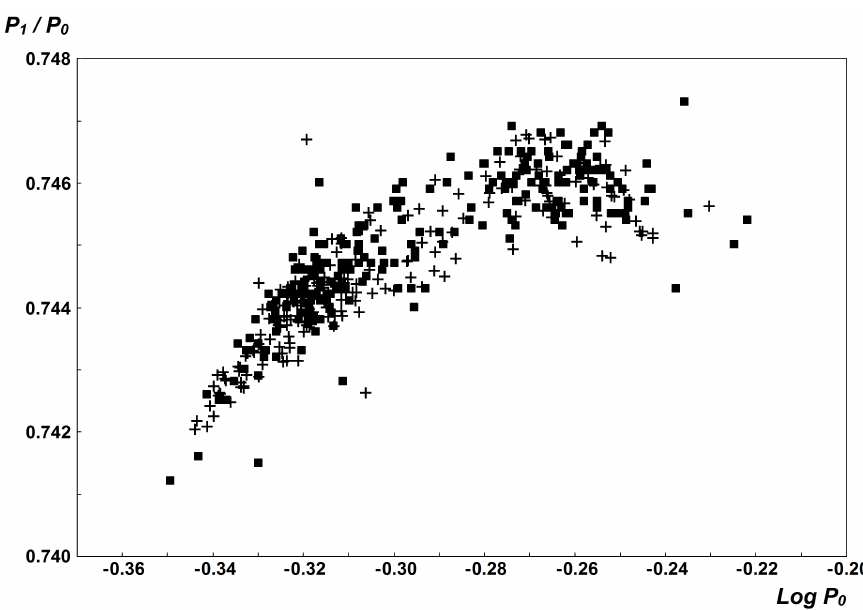
Fig. 2. The Petersen diagram for the Galactic (cid:12)eld double-mode RR Lyrae F/1O variables. The (cid:12)lled squares represent the F/1O RR(B) stars identi(cid:12)ed by us and the empty triangles denote previously known RR(B) stars (according to http://www.aavso.org/vsx/